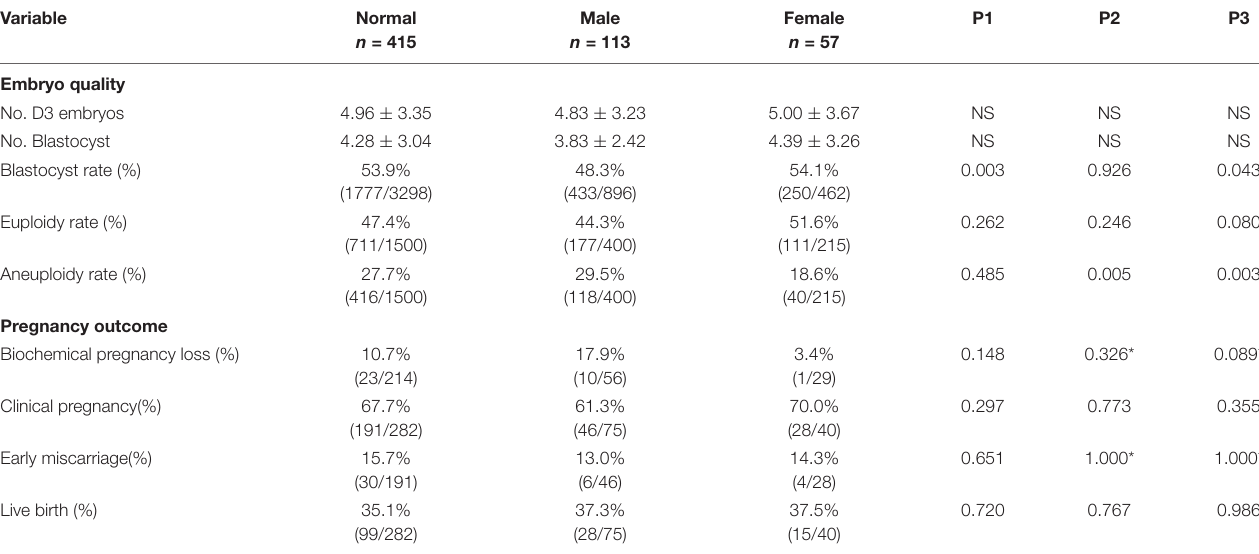
TABLE 2 | The embryo quality and pregnancy outcomes of uRPL couples.